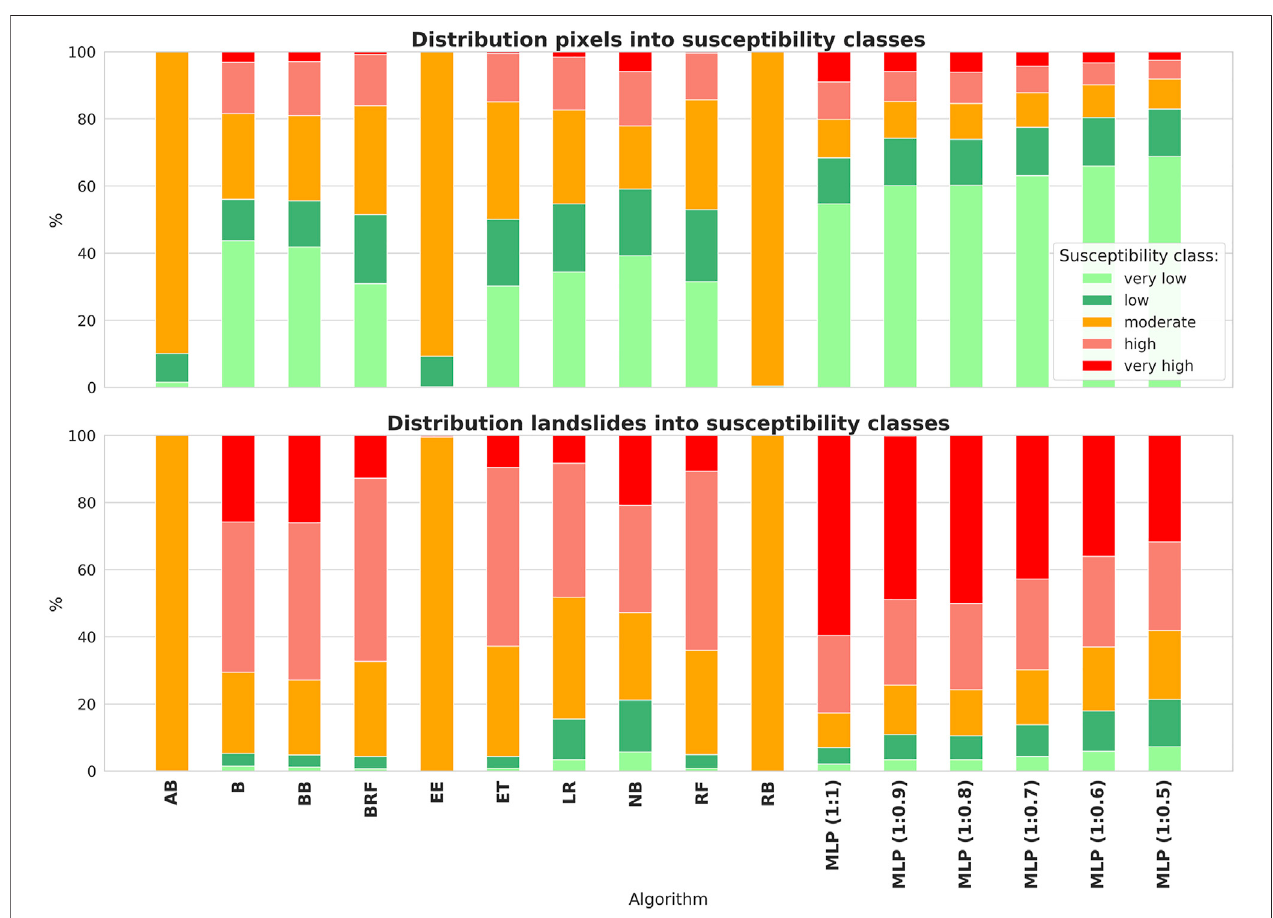
FIGURE 9 | Percentage distribution of area and landslides classi fi ed in landslide susceptibility category by each algorithm.